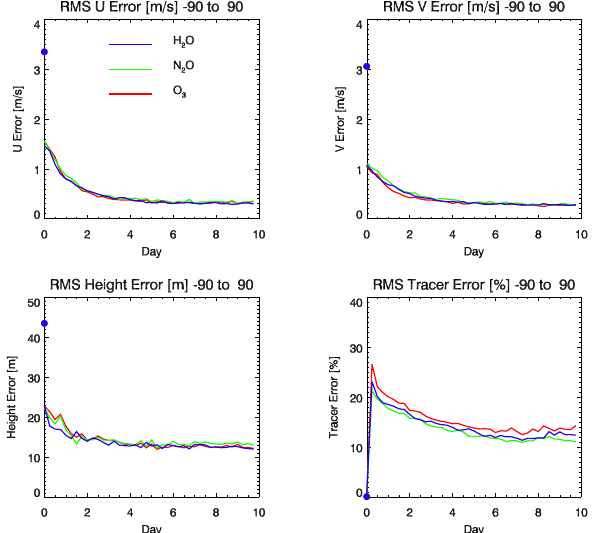
Fig. 6. RMSE for zonal wind, meridional wind, height, and tracer as a function of latitude for the BEST experiment: O 3 (red), N 2 O (green), and H 2 O (blue). Results after 10 days of cycling are shown. Units are ms − 1 for zonal and meridional wind, m for height, and tracer % relative to σ ob